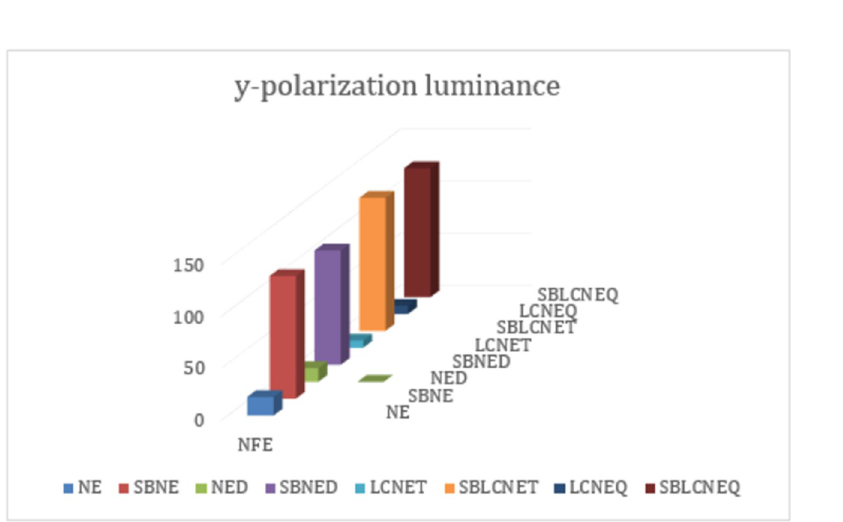
Fig 10. Near field enhancement (NFE) of normal and symmetry broken nano-elliptical structures for x- polarization luminance.